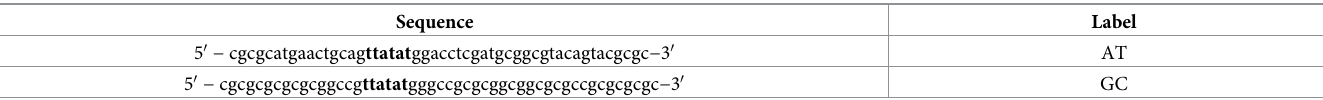
Table 1. Simulated sequences. TATA-Box location is highlighted in